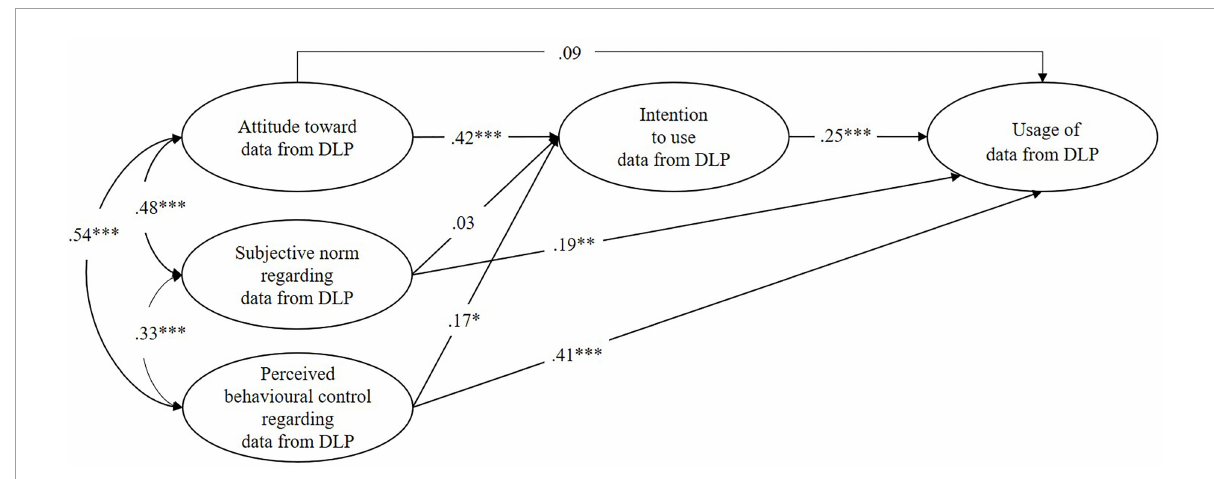
FIGURE3 Results of the structural equation modeling (SEM) for the theory of planned behavior (TPB) model in case of data from digital learning platforms (DLP). N = 272; ∗ p < 0.05, ∗∗ p < 0.01, and ∗∗∗ p <